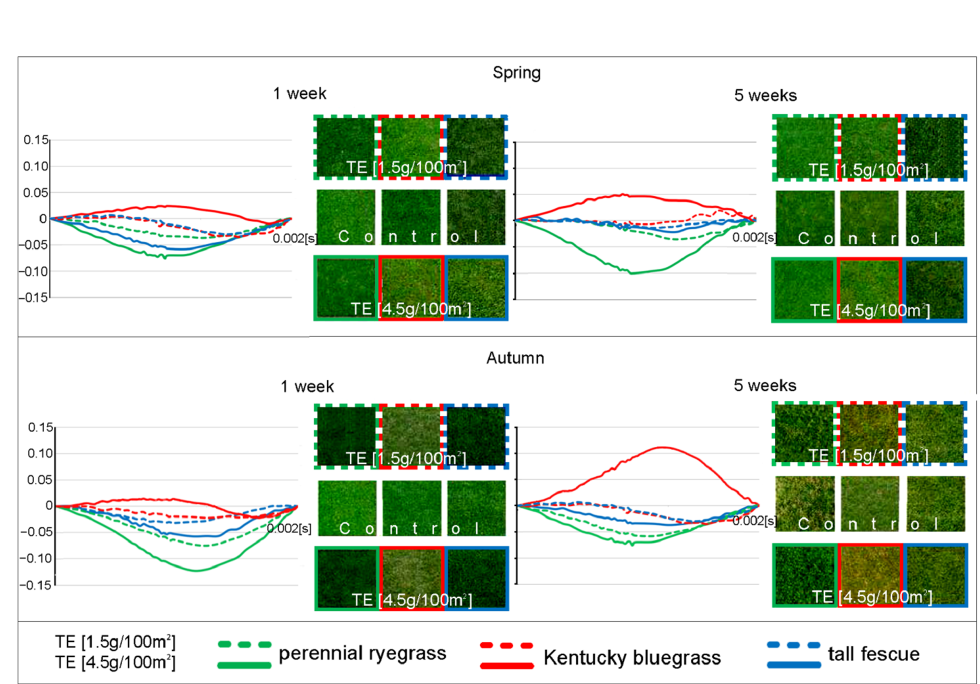
Figure 4. The influence of different TE doses, 1 and 5 weeks post-treatment, on chlorophyll a fluorescence was analyzed as ∆ W OJ curves. See methods for details of ∆ W OJ . The columns present turf photos of perennial ryegrass, Kentucky bluegrass, and tall fescue. Color code: green—perennial ryegrass; red—Kentucky bluegrass; blue—tall fescue.